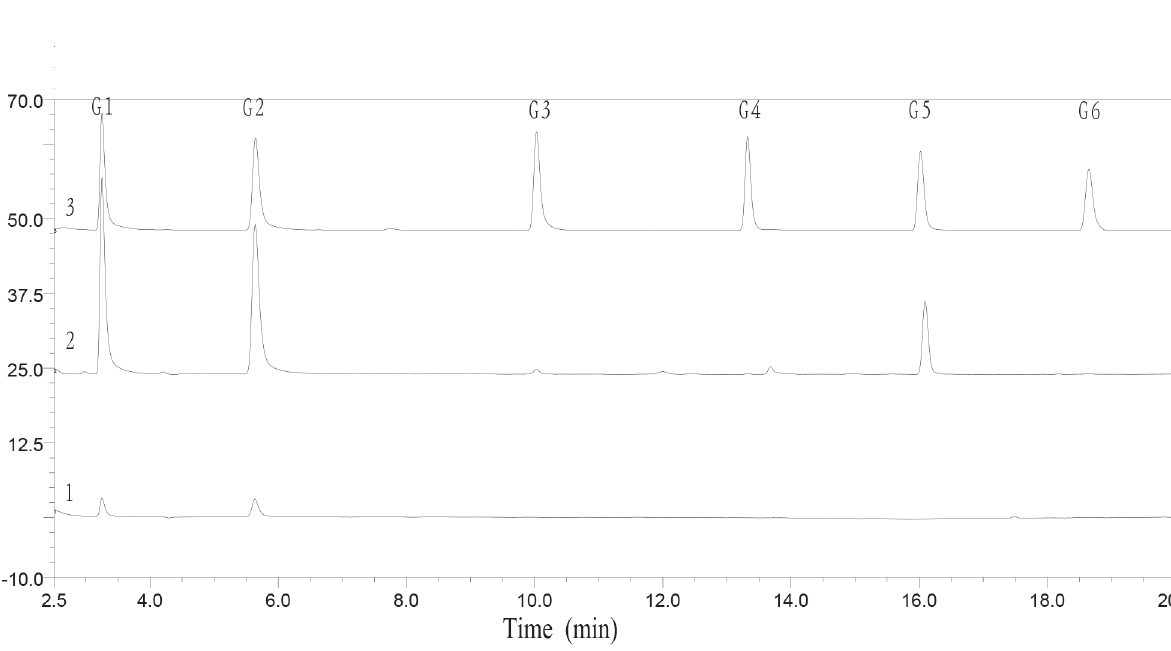
Fig 4. HPAEC analyses of the hydrolysis products of barley β -glucan and CMC-Na. 1, The hydrolysis products of CMC-Na; 2, The hydrolysis products of barley β -glucan; 3, the cellooligosaccharide standards: G1, glucose; G2, cellobiose; G3, cellotriose; G4, cellotetraose; G5, cellopentaose; G6,